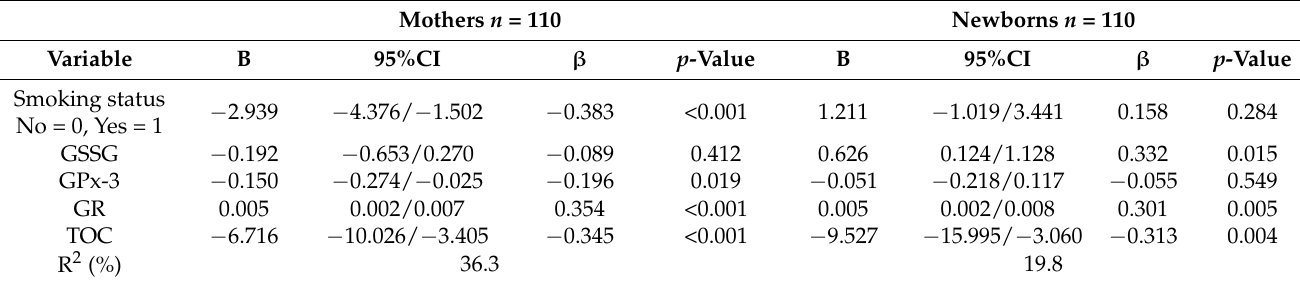
Table 2. Multivariate regression model for GSH in pregnant women and umbilical cord